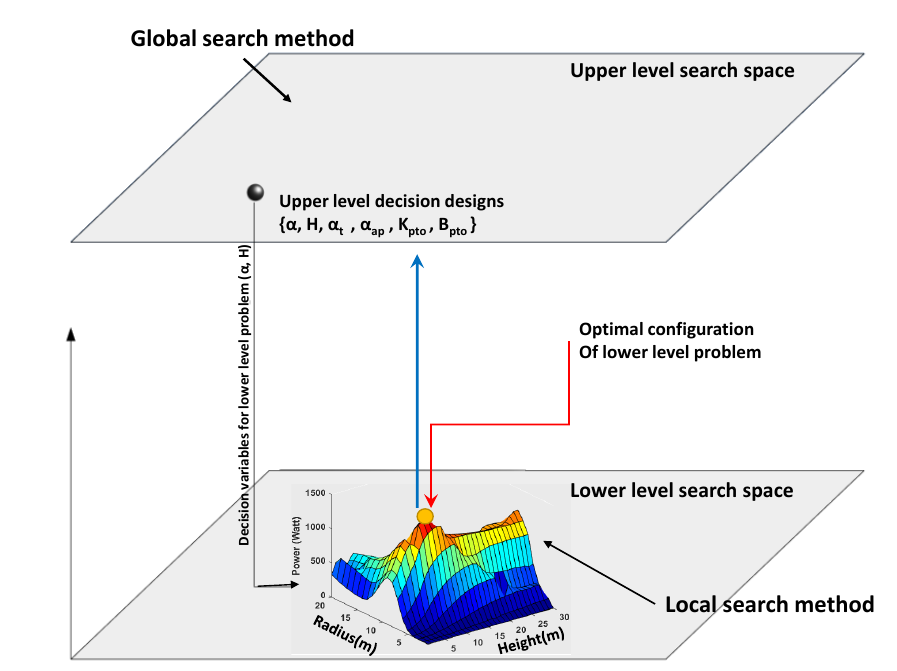
Figure 5. A general sketch of the bi-level optimisation applied in order to maximise the produced